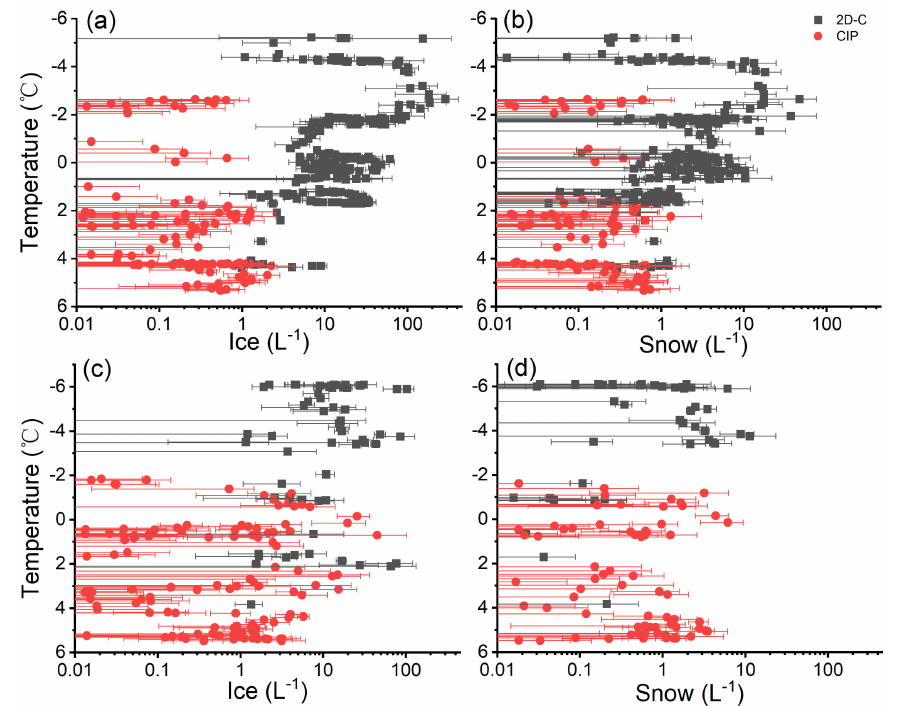
Figure 7. Variation and standard deviations with the height detected by the PMS-2D-C and the DMT-CIP probe FF: ( a ) ice crystal concentration and ( b ) snow crystal concentration. The SF: ( c ) ice crystal concentration and ( d ) snow crystal concentration (black squares: 2D-C; red circles: CIP). Standard deviations represent uncertainties in the probe